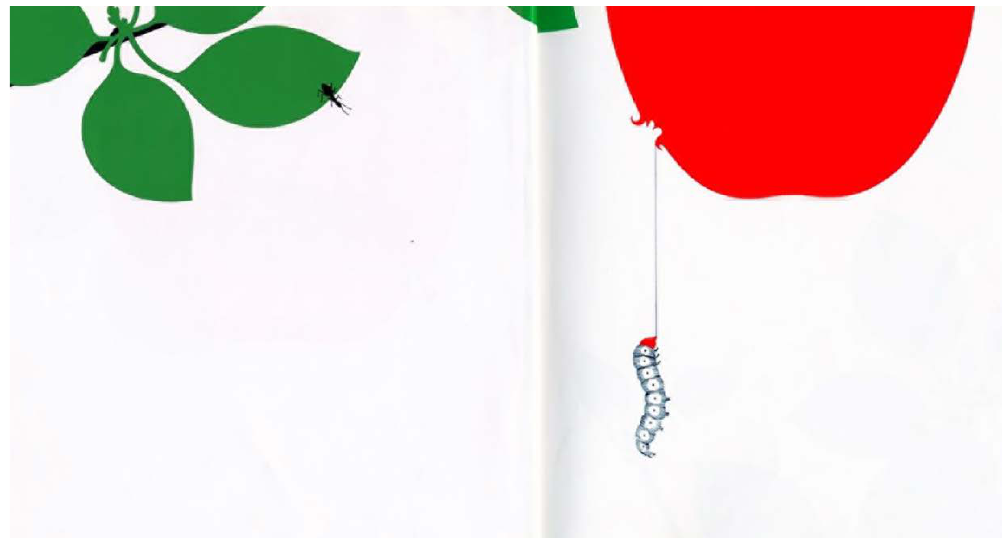
Fig. 12 Iela e Enzo Mari, La mela e la farfalla ,